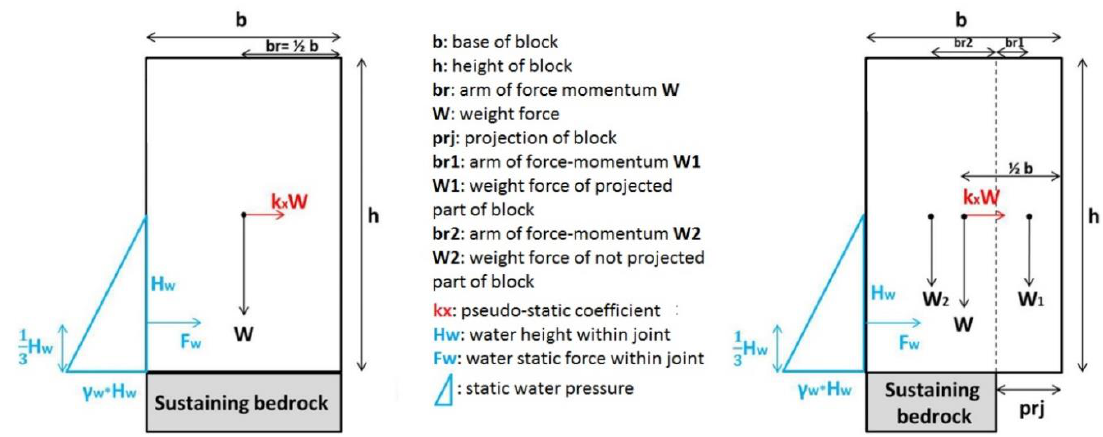
Figure 7. Two-dimensional scheme of not projecting ( left ) and projecting block ( right ) subjected to weight force, seismic pseudo-static force and water static force within the joint.